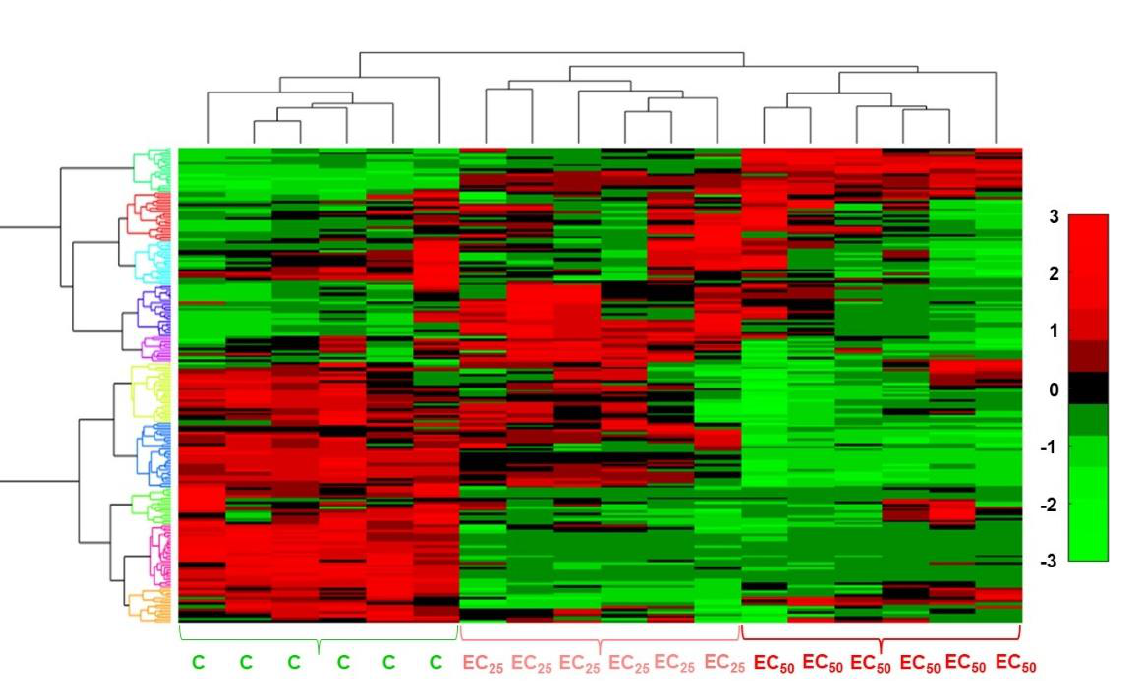
Figure 3. Effect of the Bacillus sp. PTA13 lipopeptide extract on the phenotypes of Lemna minor L. ( a – c ) and the corresponding GC/EI/MS metabolite profiles ( d – f ). The plants were exposed to con-